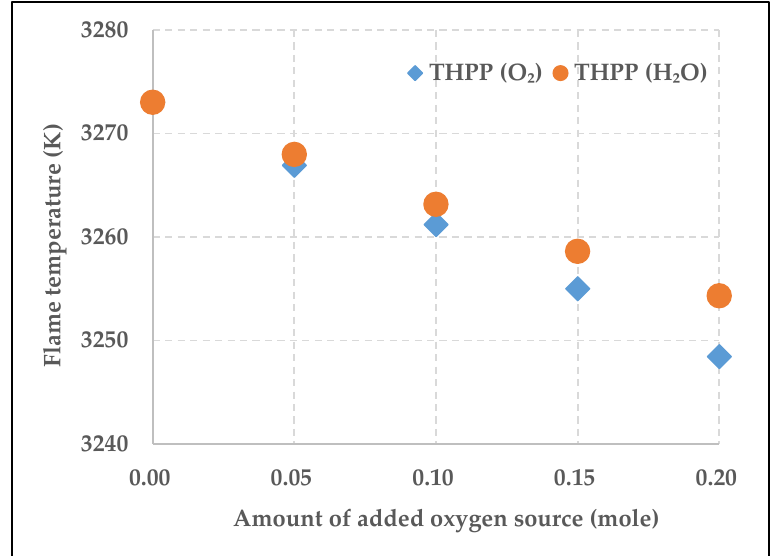
Figure 2. Flame temperature decrease of THPP correlated with the levels of oxygen sources (H 2 O or O 2 ).